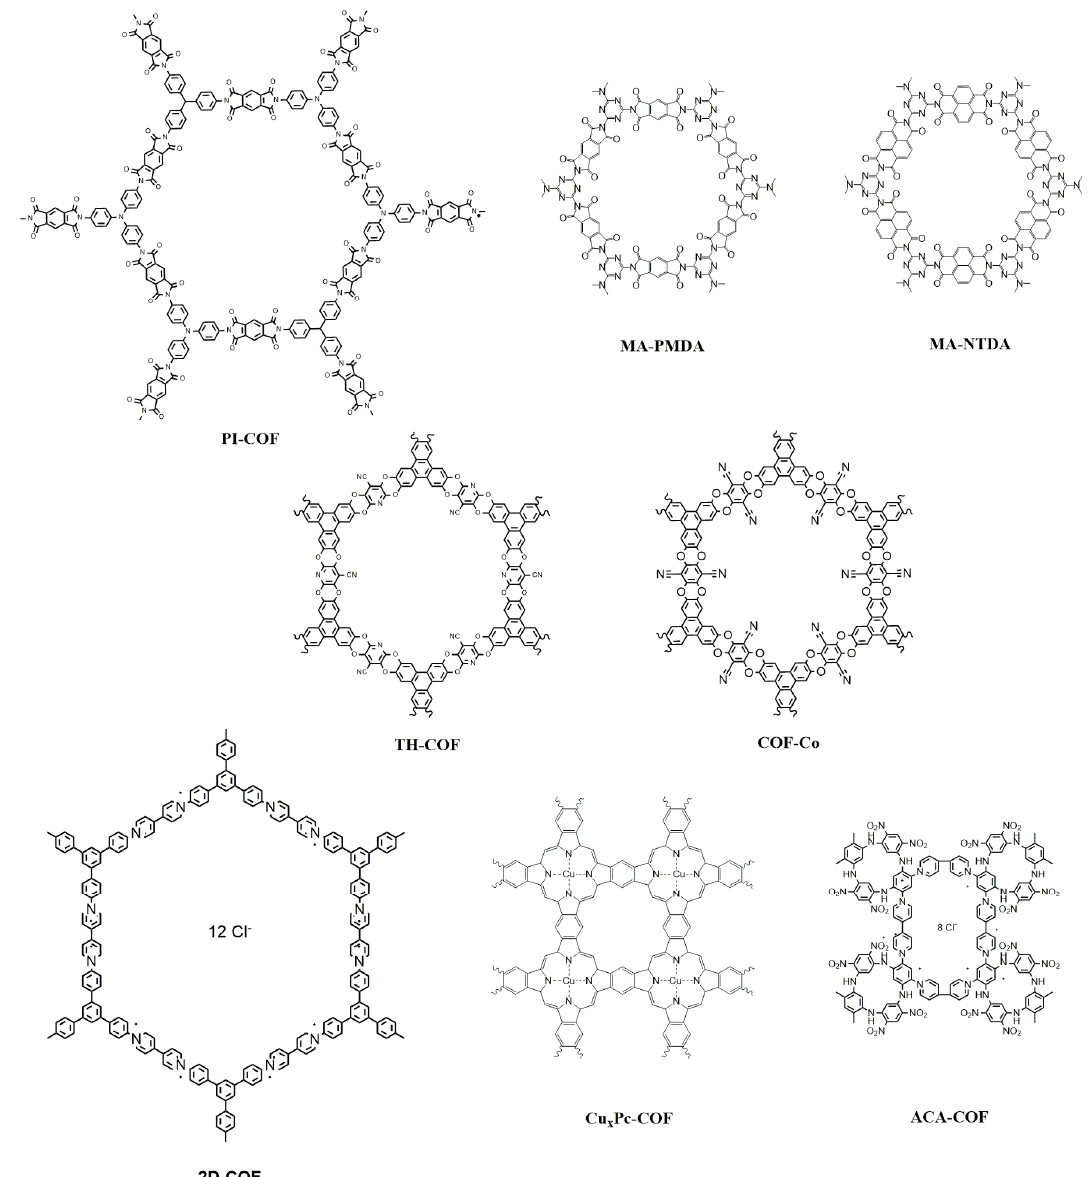
Figure 5. Structure of other COFs reviewed.